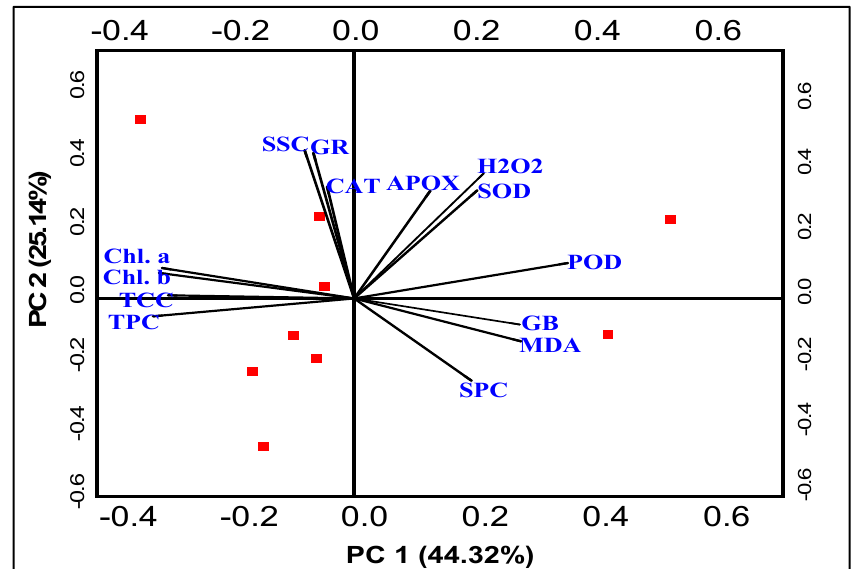
Figure 6. Principal component analysis of different physio-biochemical characteristics of A. sativa subjected to foliar sprays of AsA and/or α -toc under water deficit condition. Red squares indicate the treatments from T0 to